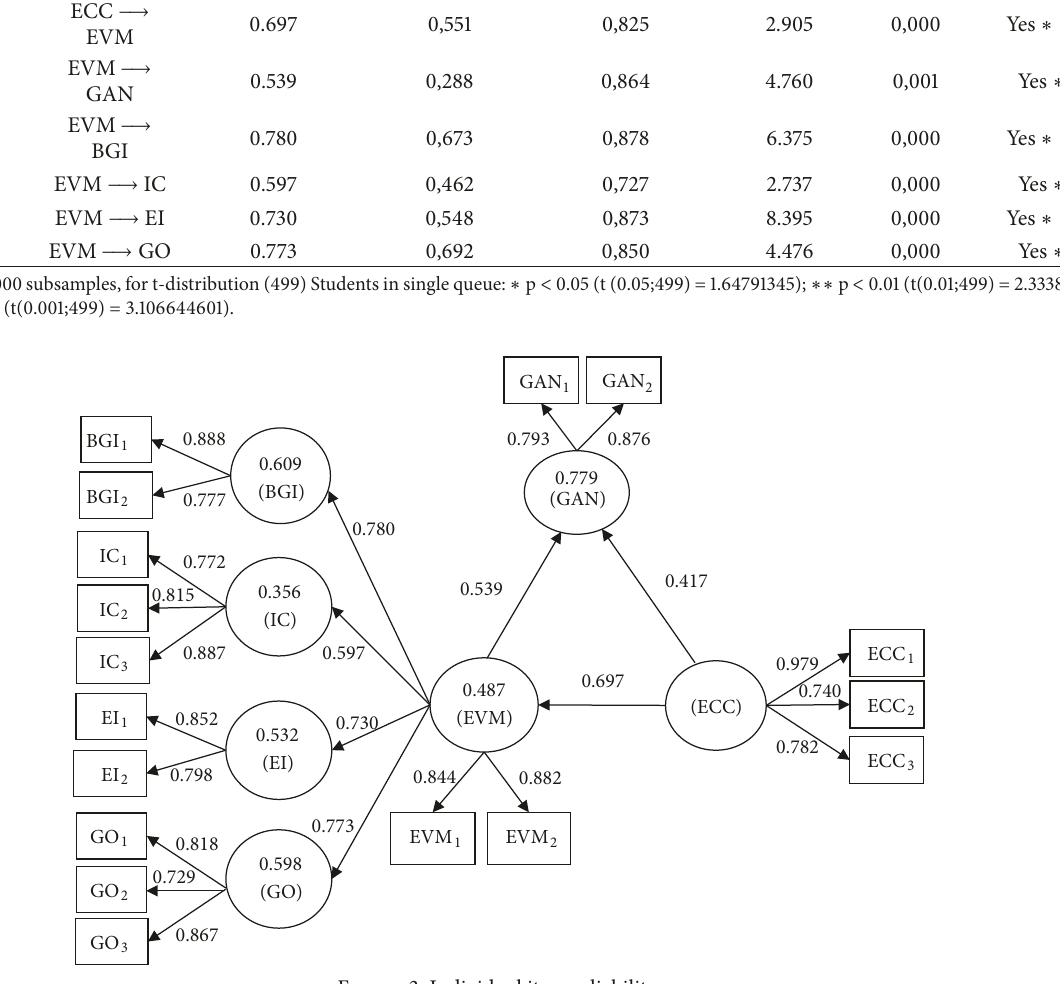
Figure 3: Individual item